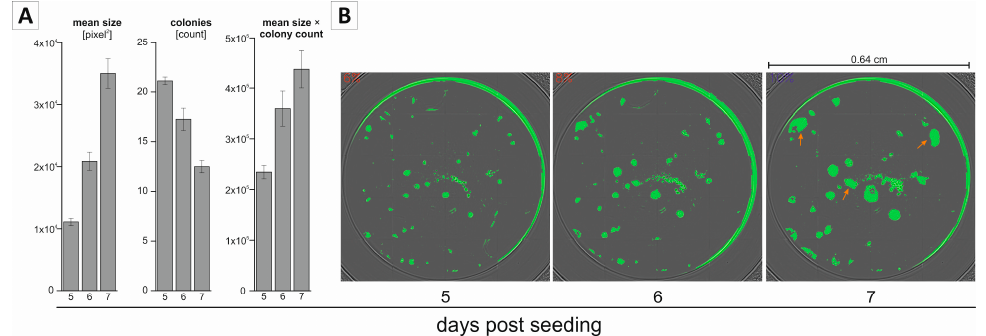
Figure 2. Evaluation of clonogenic growth in the 96-well format over time using the confluence detection. ( A ) Quantification of clonogenic growth at different time points ( n ≥ 3); ( B ) Exemplary pictures of the identical well 5, 6, and 7 days post seeding, using the confluence detection function. Green spots represent areas detected as confluent by the confluence module. Orange arrows indicate merged colonies.